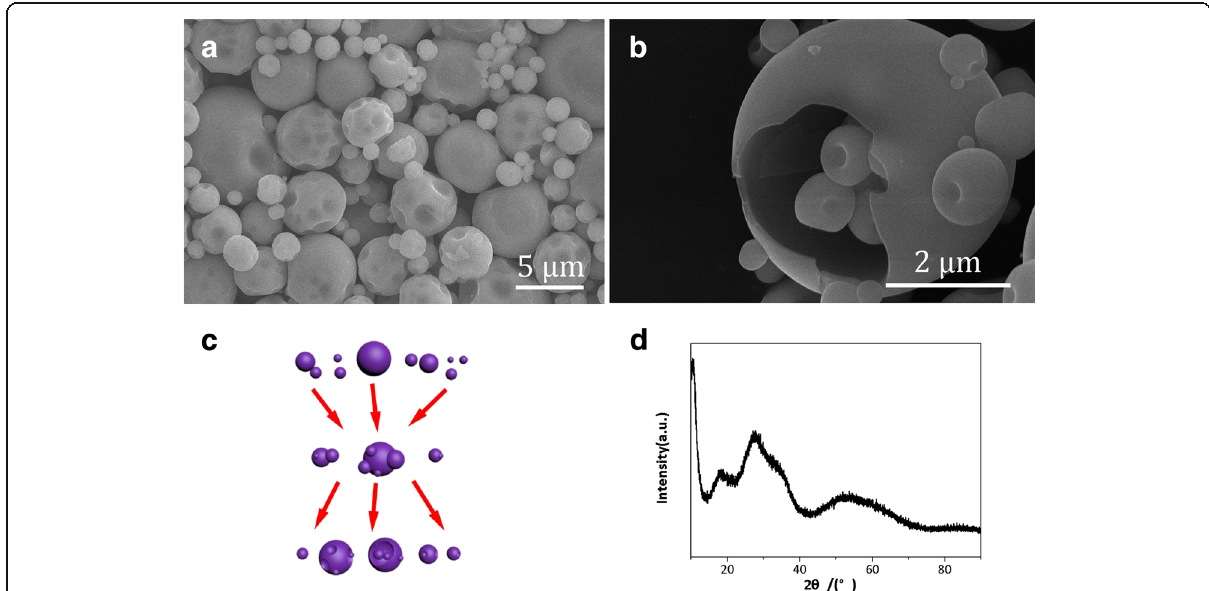
Fig. 3 The microstructure and XRD pattern of spray-dried (NH 4 ) 6 W 7 O 24 ·6H 2 O particles. a , b The morphology of the (NH 4 ) 6 W 7 O 24 ·6H 2 O particles atomized by spray drying method. c The schematic of collision between particles. d The XRD pattern of spray-dried (NH 4 ) 6 W 7 O 24 ·6H 2 O